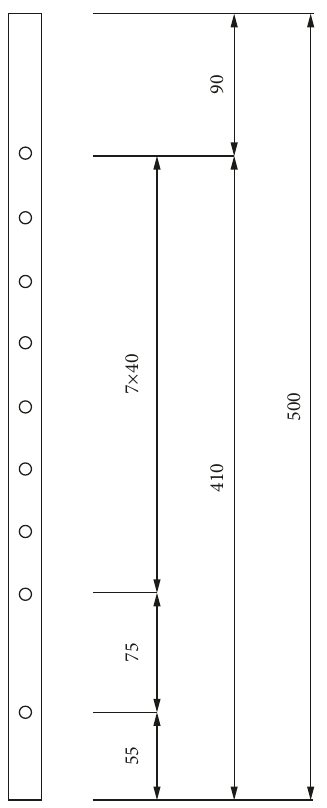
Figure 2: Schematic diagram of pile (mm).